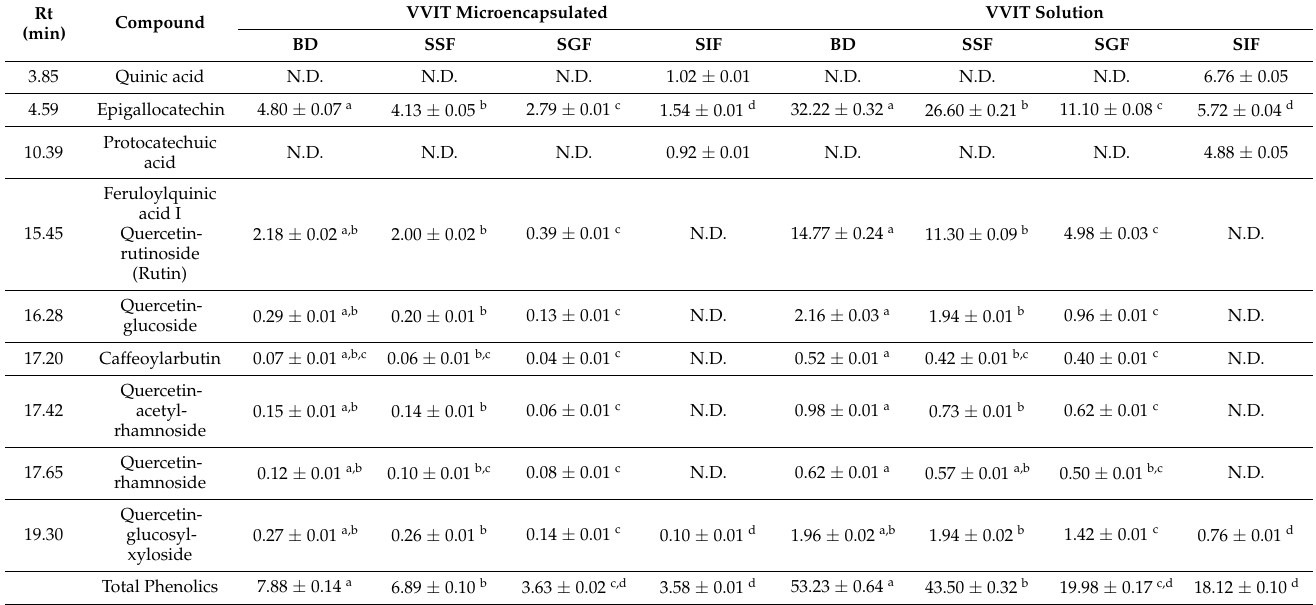
Table 5. Effect of salivary, gastric and intestinal in vitro digestion model on the phenolic content of VVIT